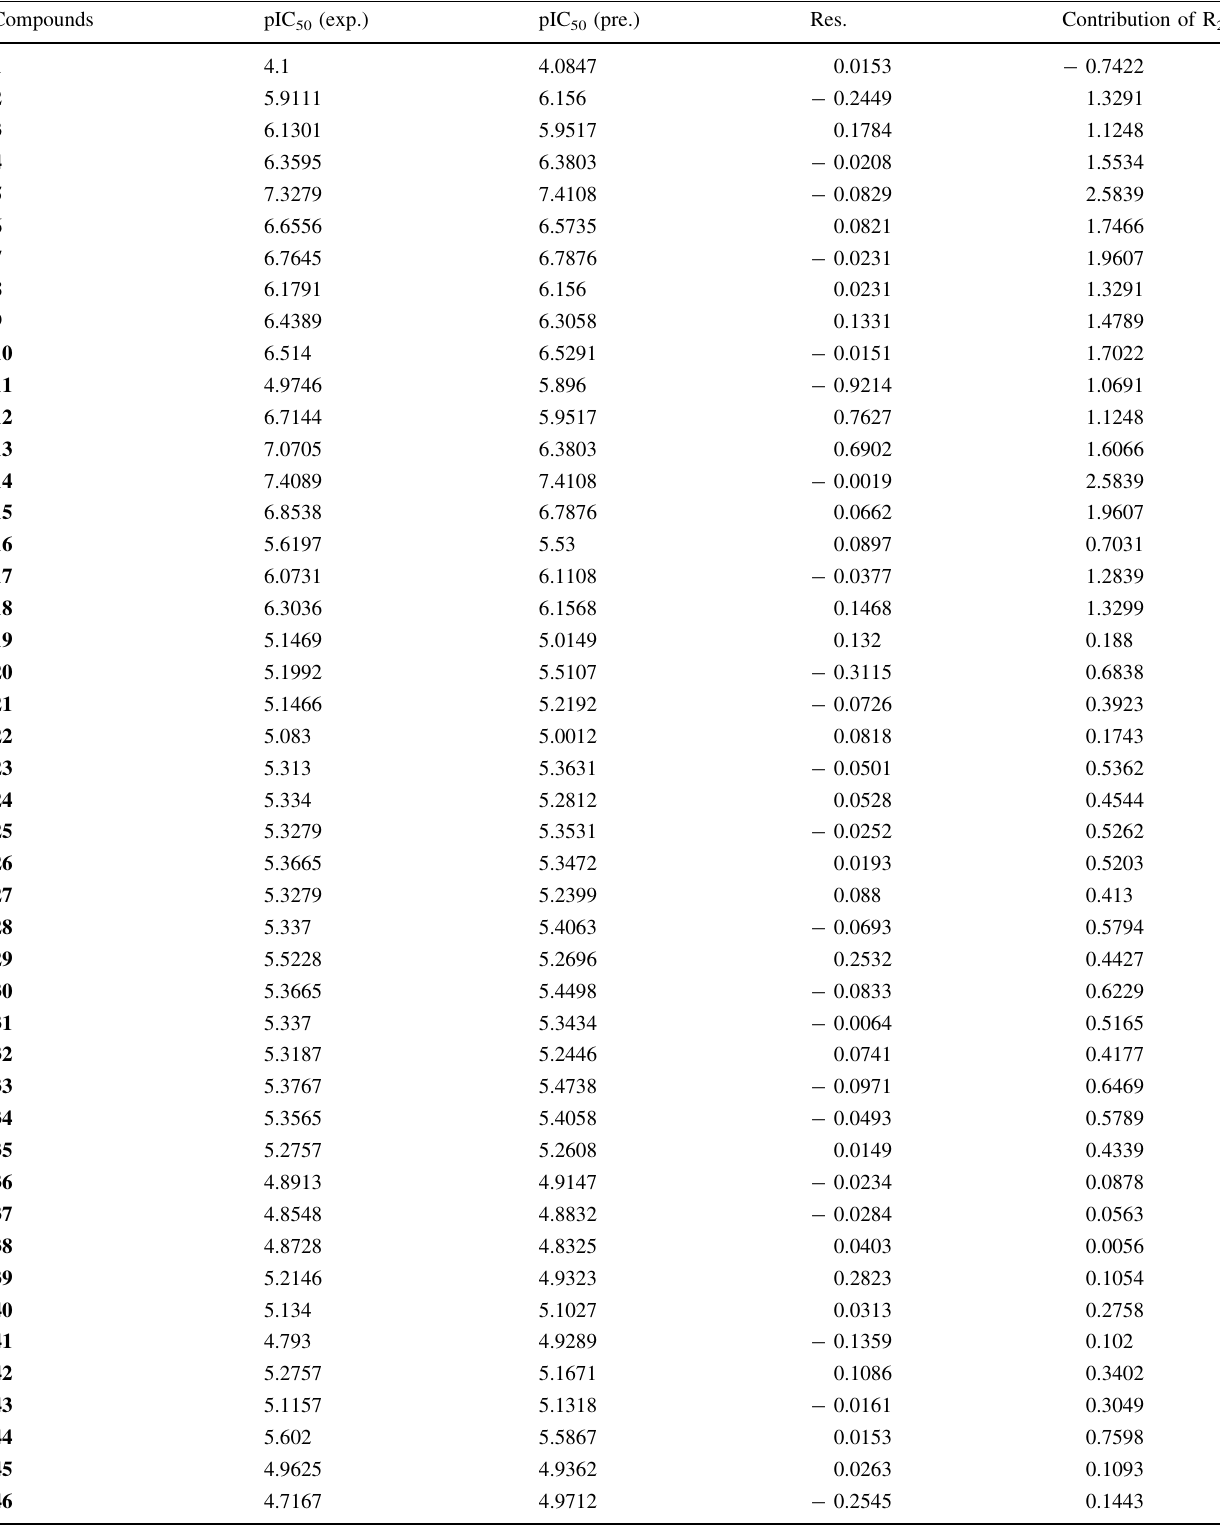
Table 3 Experimental and predicted data of all compounds using topomerCoMFA with contribution values of each fragment Compounds pIC 50 (exp.) pIC 50 (pre.)